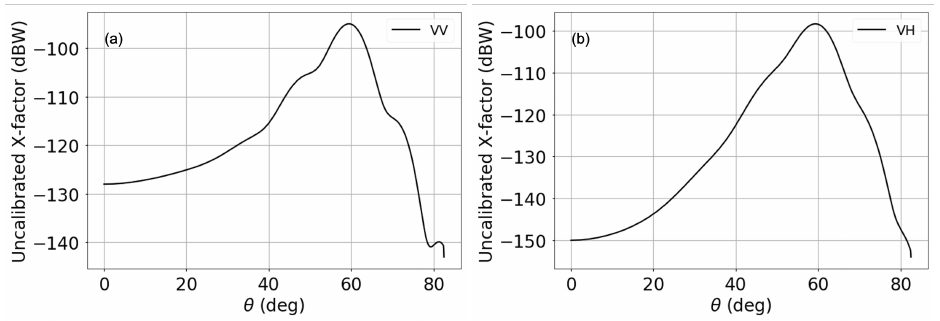
Figure 5. Uncalibrated X − factor for VV ( a ) and VH ( b ) polarizations as a function of the incidence